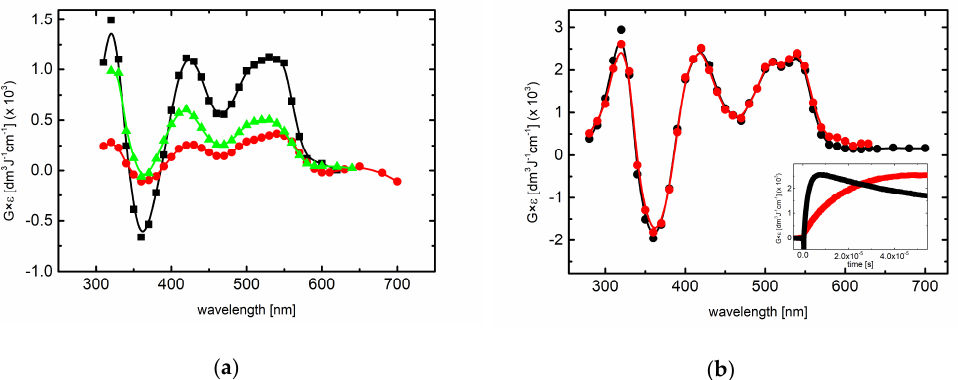
Figure 4. ( a ) Transient absorption spectra recorded in aqueous solutions containing 0.1 mM 7-OCH 3 -3-MeQ: ( ) `5 μs after the electron pulse in Ar-saturated solutions containing 10 mM K 2 S 2 O 8 and 0.5 M tert -BuOH at pH 4.4, ( ) 8 μs after the electron pulse in N 2 O-saturated solutions containing 0.1 M NaN 3 at pH = 7, ( ) 40 μs after the electron pulse in N 2 O-saturated solutions containing 5 mM TlCl at pH = 3; ( b ) Transient absorption spectra recorded in aqueous solutions